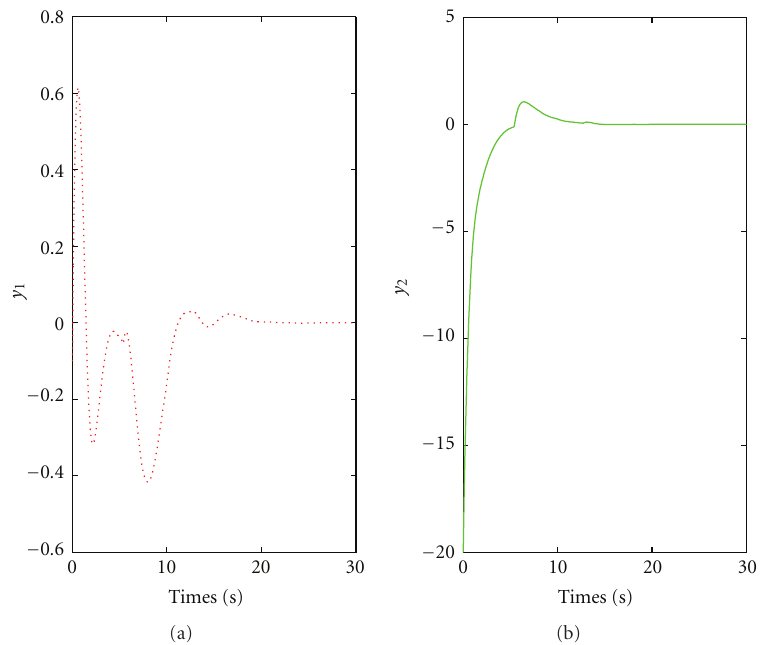
Figure 1: State responses of the closed-loop system for z 1 ( s ) = z 2 ( s ) = 1 − | s − 1 | , 0 ≤ s ≤